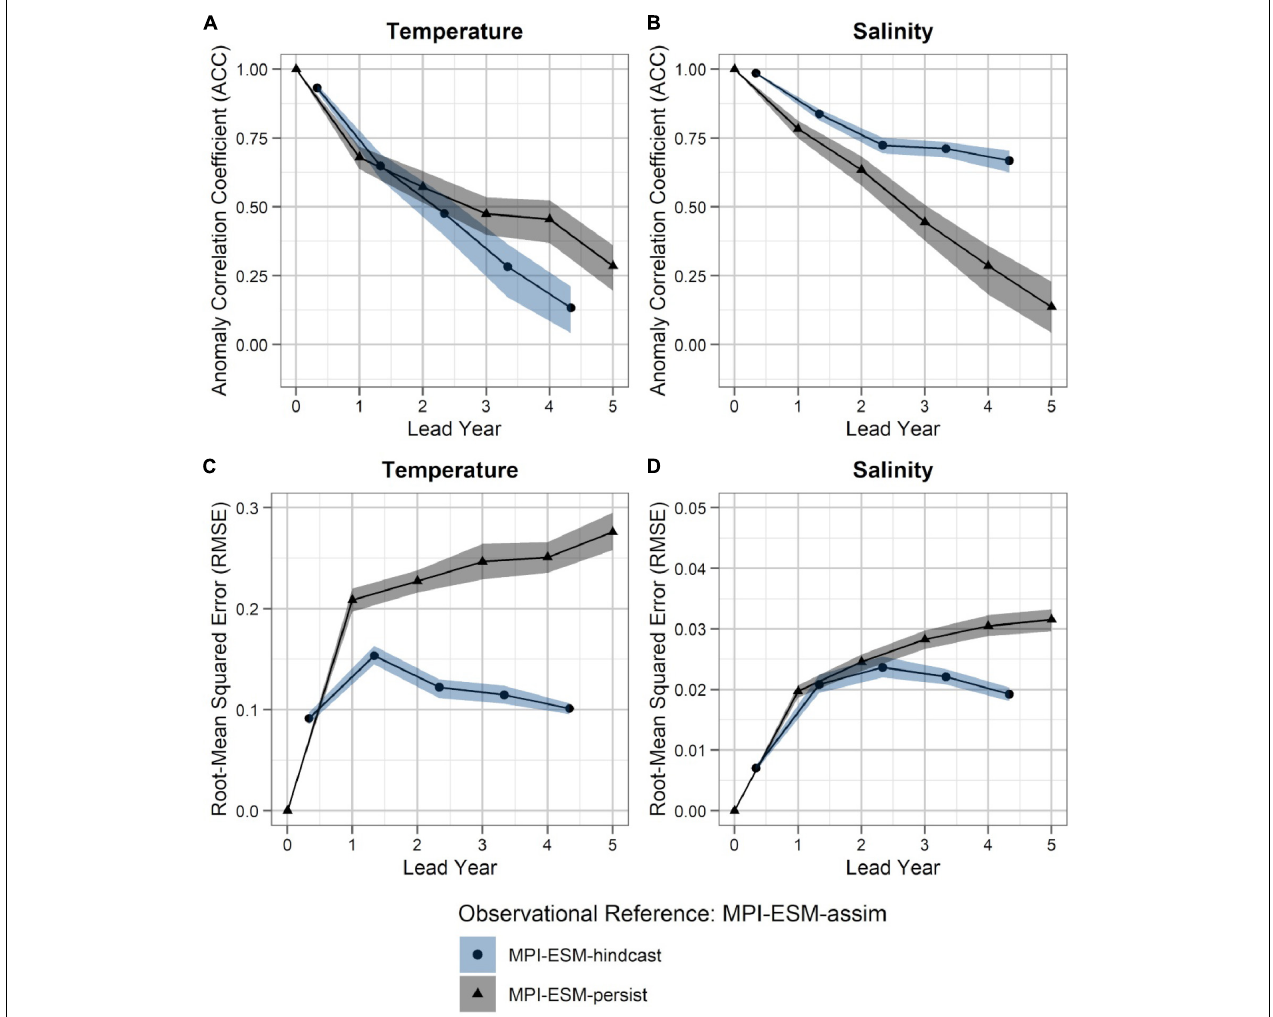
FIGURE 4 | Predictability of temperature (left; A,C ) and salinity anomalies (right; B,D ) averaged over 250–600 m in FMA within the spawning region (black rectangle in Figure 1 ), measured in terms of the anomaly correlation coefficient (ACC; top row) and root-mean squared error (RMSE; bottom row) of MPI-ESM-hindcast (bullet; blue area) and MPI-ESM-persist (triangle; grey), judged against MPI-ESM-assim . The connected bullets/triangles indicate the median and the blue/grey shaded areas indicate spread based on the lower and the upper quartile of a 500-fold bootstrap. Two correlations (or RMSEs) are markedly different when their respective shaded areas show no